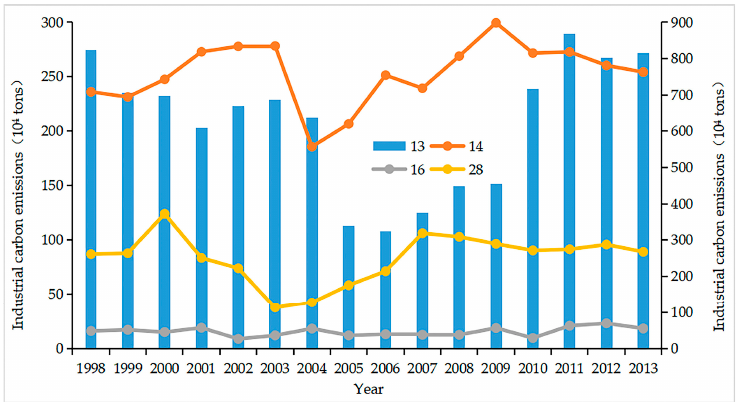
Figure 8. Changes in the Carbon Emissions of the Basically Stable Type Industries in Guangdong from 1998 to 2013.